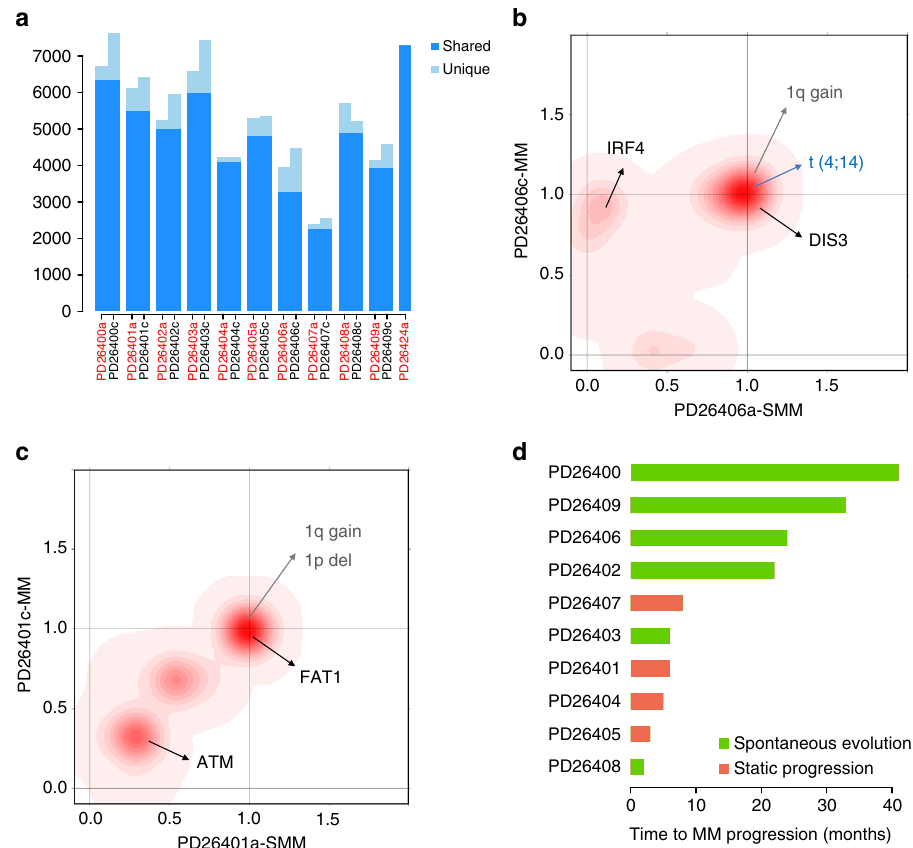
Fig. 2 The genomic landscape of smoldering MM progression into symptomatic MM. a Comparison of substituion burden between SMM and MM, where dark blue represents shared mutations, and light blue mutations private to either sample. b Two-dimensional density plots showing the clustering of the fraction of tumor cells carrying each mutation at each time point; on x -axis and y -axis are plotted the SMM and MM phase, respectively. Increasing intensity of red indicates the location of a high-posterior probability of a cluster. In this case (PD26406), we have three main clusters, one was shared by 100% of cells both in SMM and MM; one was present only during the smoldering phase, and one appeared during progression. This is a typical example of spontaneous evolution model. c In this sample, no signi fi cant changes occurred in all main three clusters at progression. This is a typical example of the static progression model. d Time to progression of each case, where spontaneous evolution cases are in green, and static progression cases are in